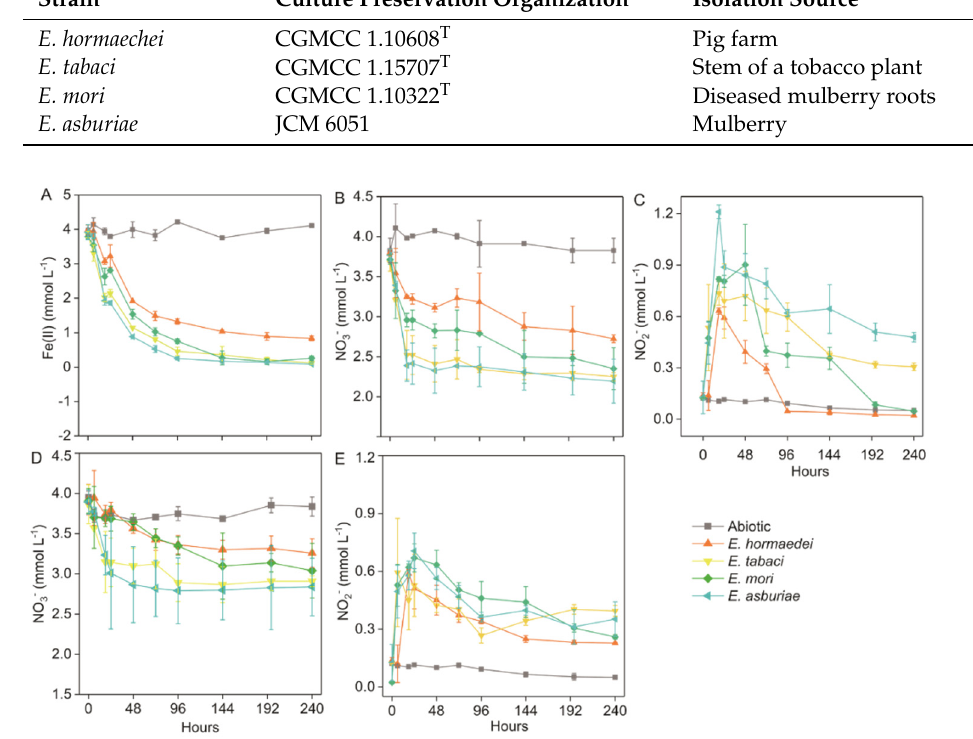
Figure 1. Time course of Fe(II), NO 3 − and NO 2 − for Enterobacter strains in the NRFO medium containing with ( A − C ) and without ( D , E ) iron(II) during the incubation. The error bars indicated the standard deviations of three replications.